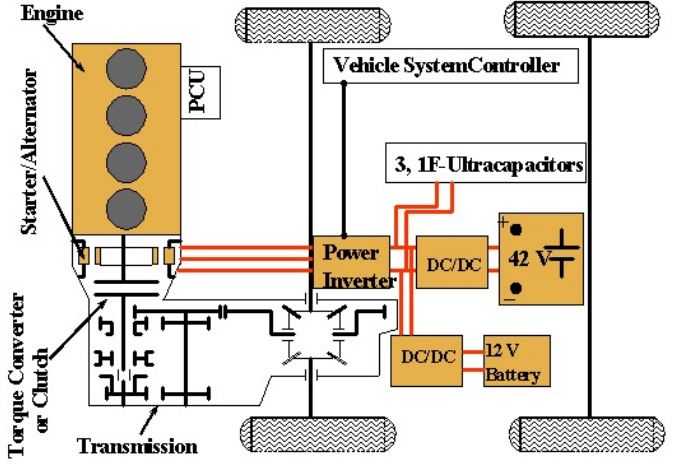
Figure 9. The ISA system design.